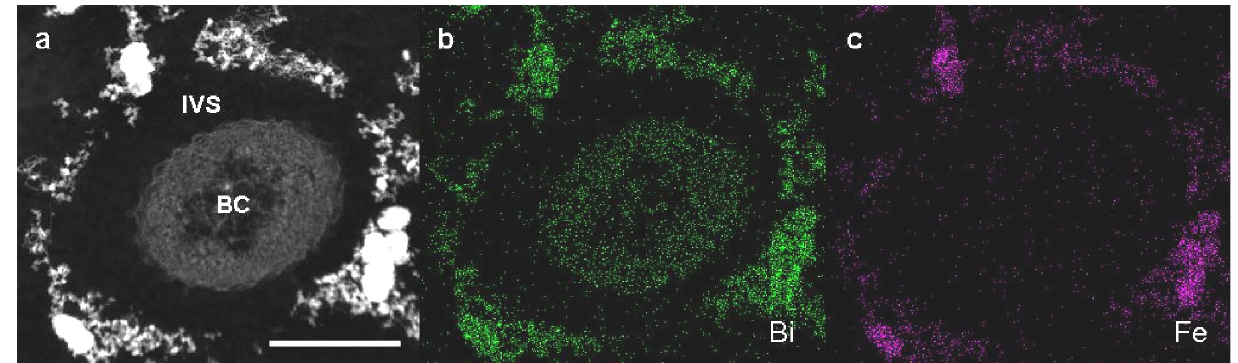
Figure 3. High-angle annular dark-field scanning transmission electron microscopy (HAADF-STEM) images of sheathless mutant (SL) of Leptothrix sp. strain OUMS1 and associated structures in Bi-stained cross sections prepared from 3-day culture in